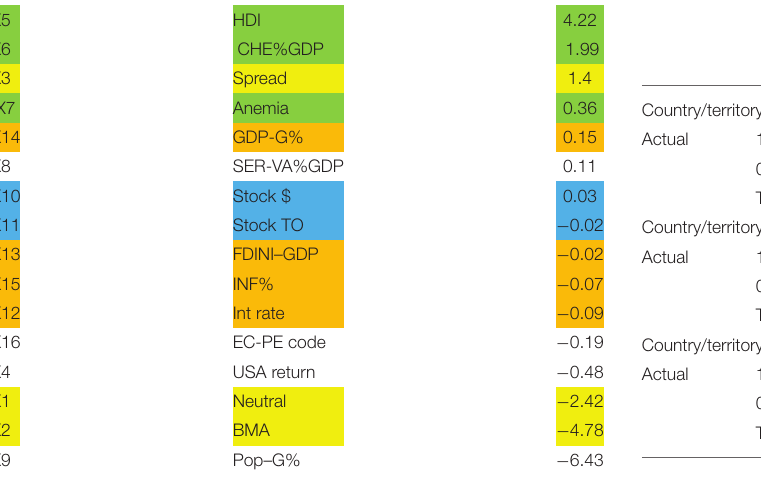
TABLE 19 | Confusion (classification)